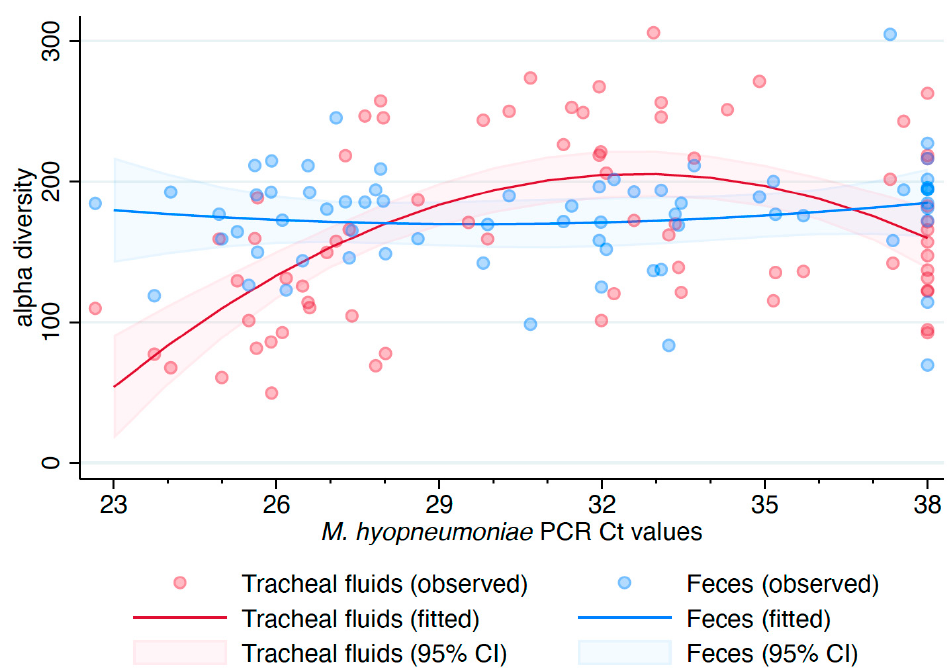
Figure 2. Association of alpha diversity (inverse Simpson index) with sample type and Mycoplasma hyopneumoniae real-time PCR Ct values in tracheal fluids. 95% CI: 95% confidence interval.